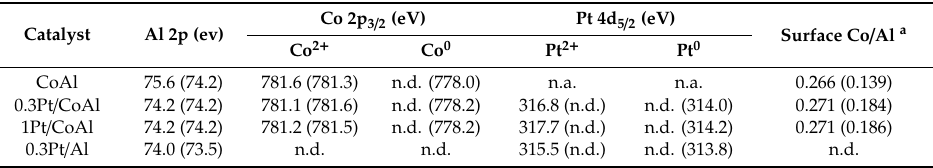
Table 3. Binding energy values from XPS analysis.